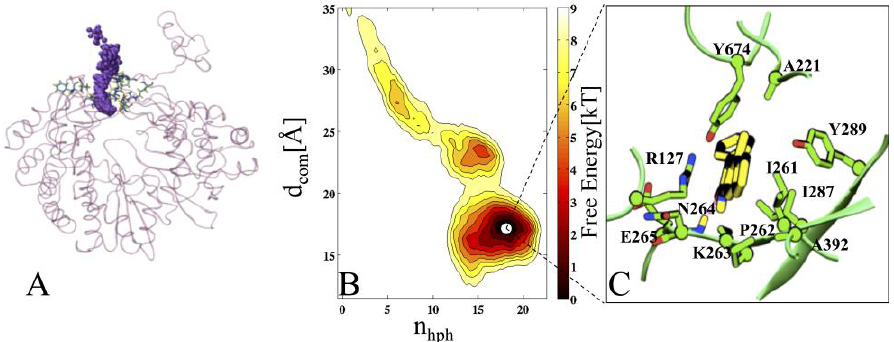
Figure 6. Characterization of 5m unbinding during metadynamics simulation. ( A ) The starting state of 5m. ( B ) The two-dimensional free-energy surface (FES) of 5m in COM2, and its dissection according to the minima obtained during the unbinding process. Each color and each line of FES correspond to 1 kcal/mol. ( C ) Conformation representing the state of 5m in COM2, enlarged from mini-1. The FES of 2h is ~10 kcal/mol. The free energy is contoured in steps of 2 kcal/mol up to 10 kcal/mol. In panel ( C ), the inhibitor 2h is represented in yellow, and residues acids are shown in green. The red dotted line represents the HB between residues and 5m.